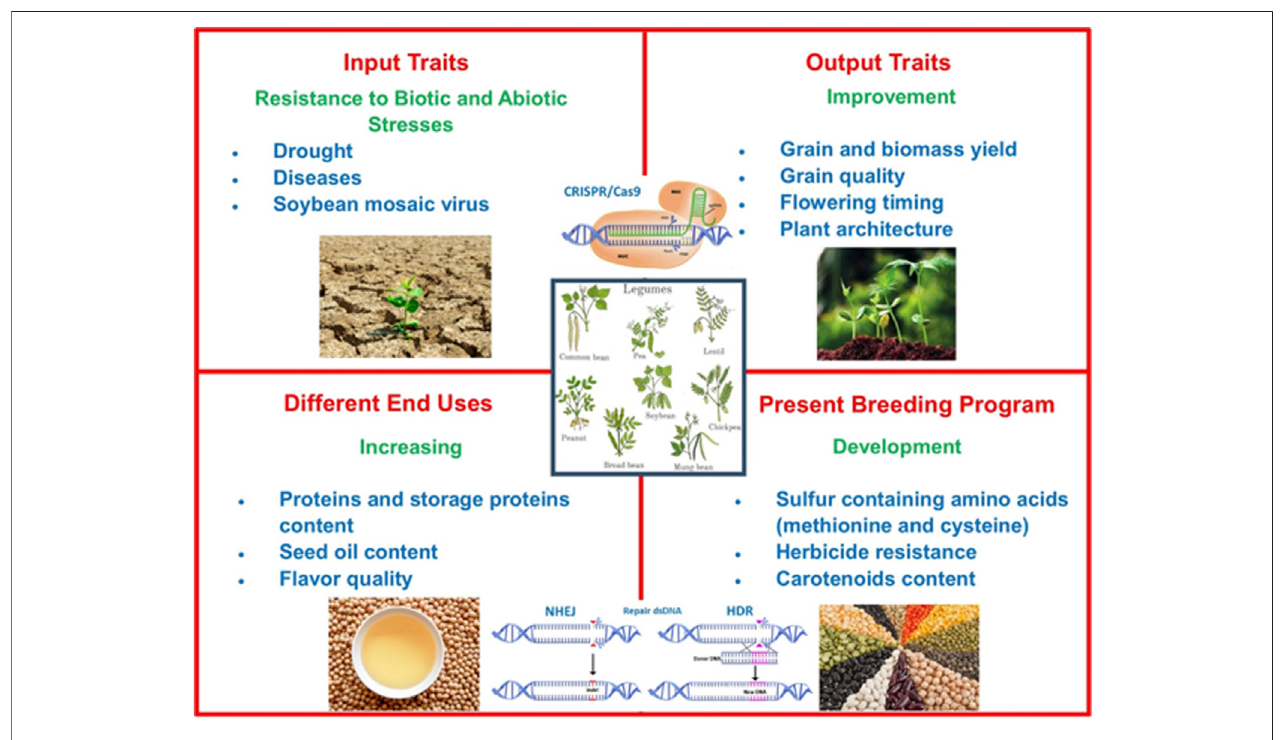
FIGURE 3 | Strategies for improving legume